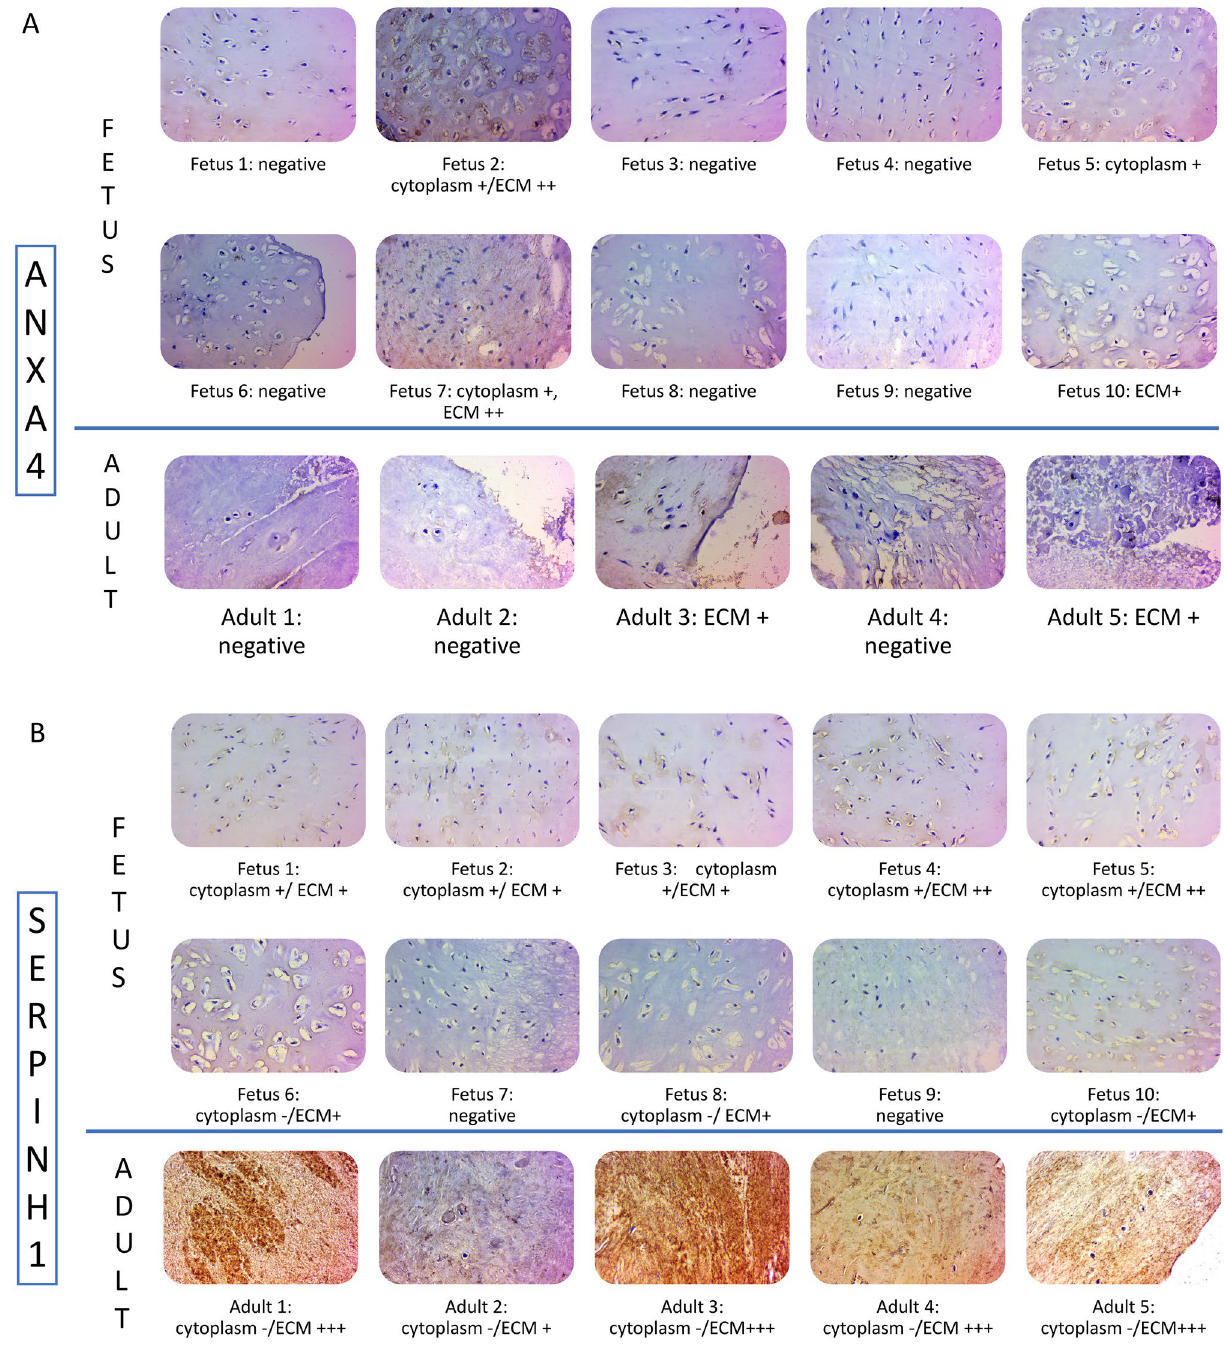
Figure 5. Validation by immunohistochemistry. Immunohistochemistry was used to validate protein expression of SEPRINH1 in ( A ) and ANXA4 in ( B ) (magnification 400x, scale bar = 50 µm). Positive samples are stained brown. Both location and intensity are stated under the pictures: + indicates mild staining, ++ moderate and +++ strong